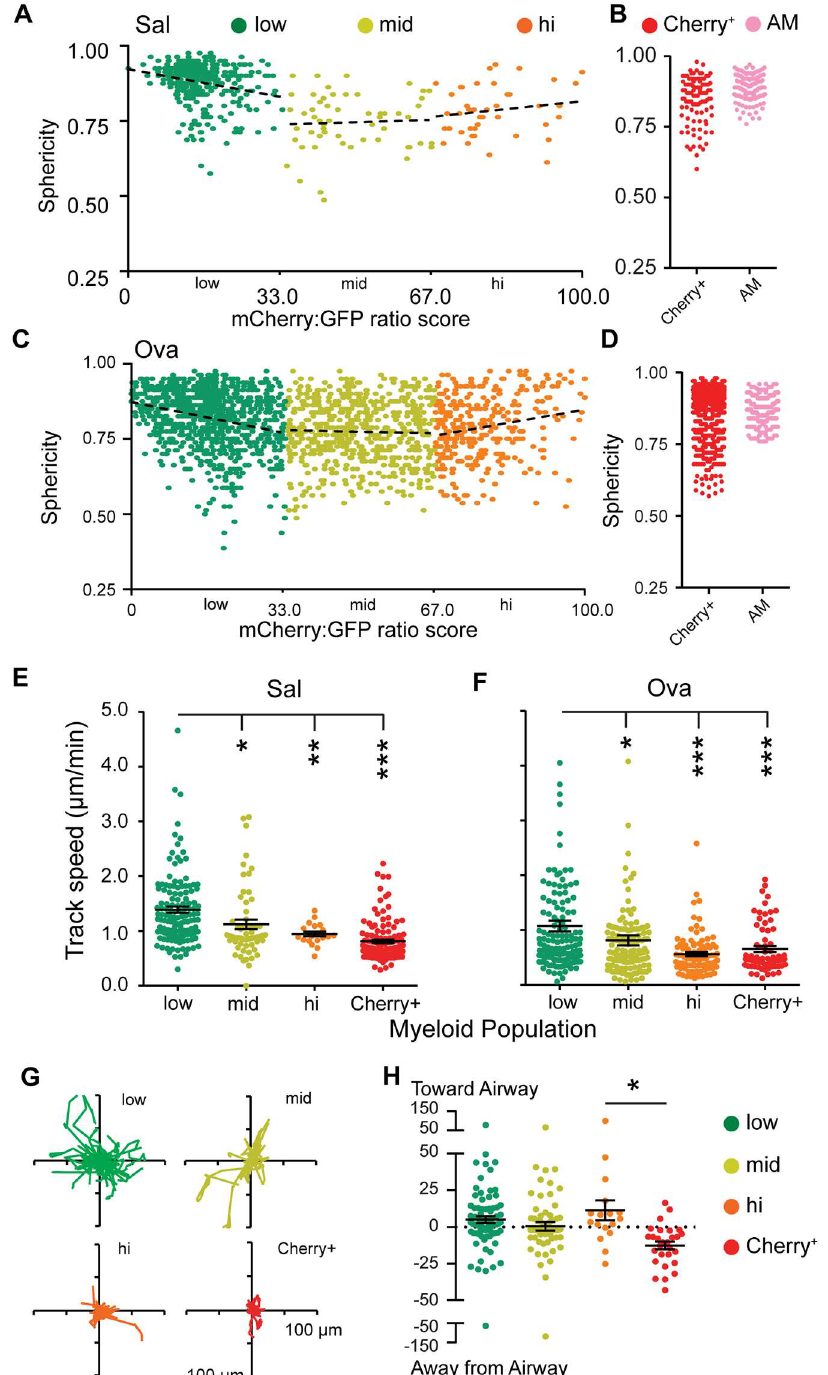
Fig 3. Increased sphericity and reduced motility of monocyte-derived populations as they differentiate in inflamed mouse lungs. ( A,C ) Sphericity of GFP + leukocytes in control (A) or Ova-treated (B) lungs categorized into divisionsbased on Cherry:GFP ratio score or Cherry + only cells and AMs. ( B,D ) Normalized trajectories of cells in panels A and B respectively(Also see S1 Video). ( E,F ) Track speed mean of cells in panels A and B respectively. * p < 0.05; ** p < 0.005; *** p < 0.001. (Pairwise t-test compared to ratio low cells). ( G ) “Flower” displacement plots of 20 randomly selected tracks from each differentiation bin. ( H ) Track displacements of cells from panel A with respect to the airway. Positive numbers indicate